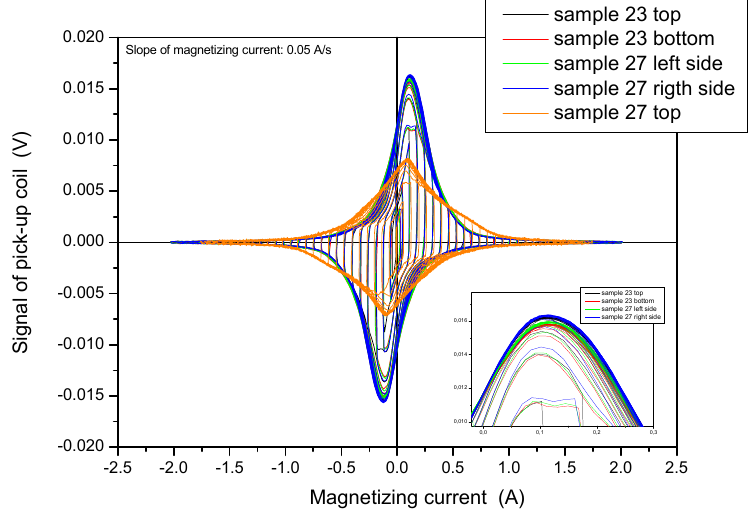
Figure 7. Permeability curves of the reference sample (sample 23) measured on top and bottom sides, and permeability curves of mechanically treated sample 27 measured on the top and on two sides. Insert: magnified part of the graph.